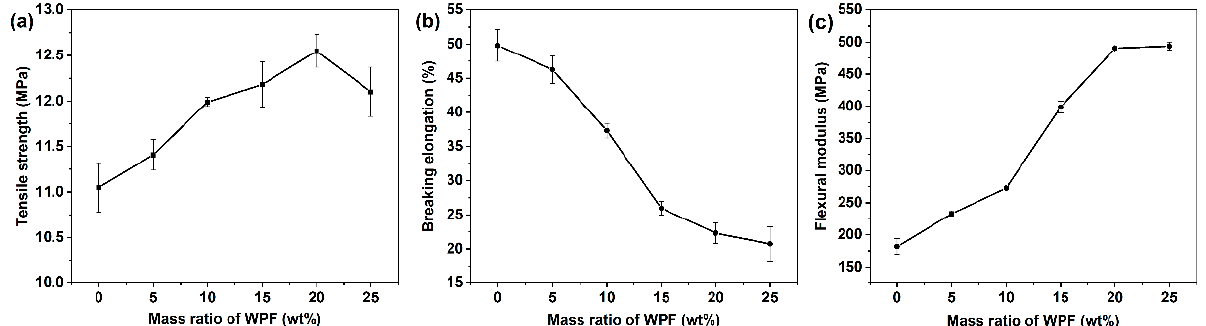
Figure 1. The mechanical properties of RPE/WPF composites with different WPF content: ( a ) tensile strength, ( b ) elongation at breaking, ( c ) flexural modulus.